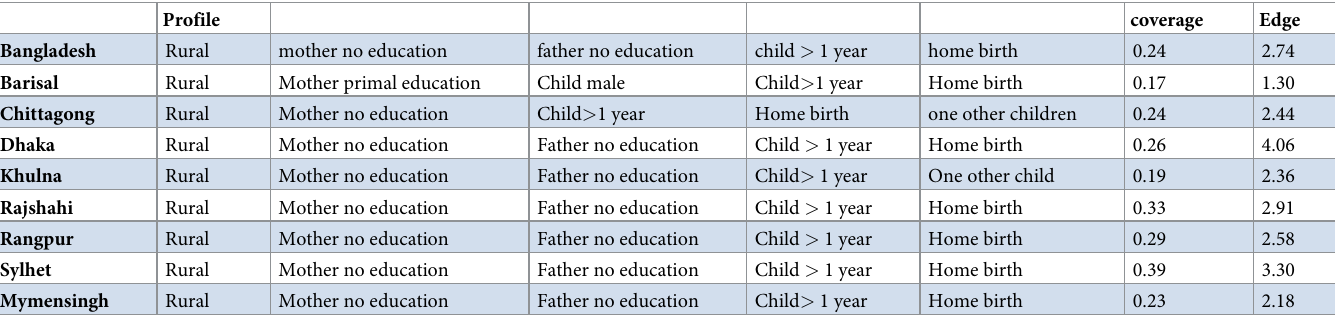
Table 1. Polling results from 1996 (new WHO).